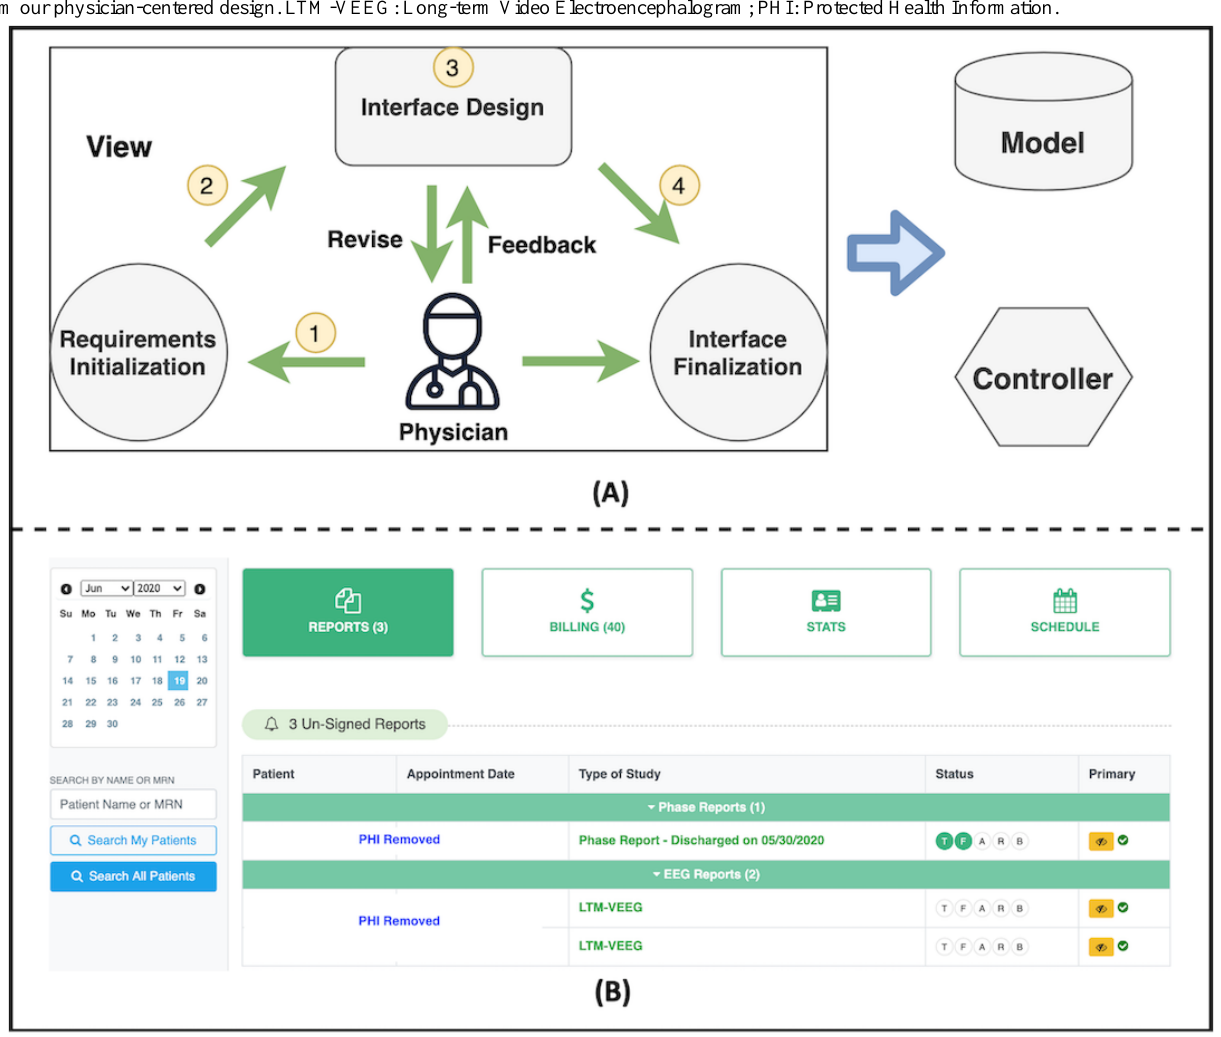
Figure 1. (A) Steps involved in our physician-centered design and interface-driven development process; (B) Exemplar physician dashboard